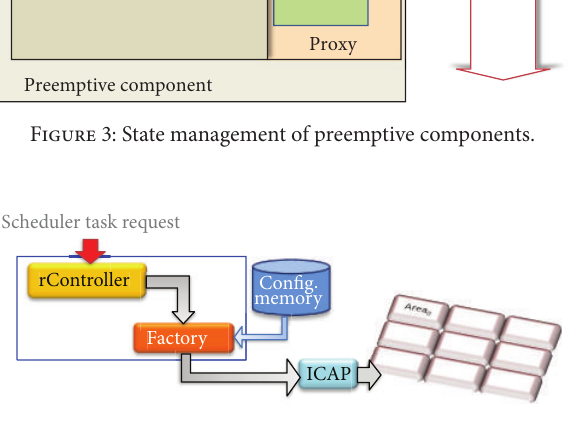
Figure 4: Dynamic reconfiguration